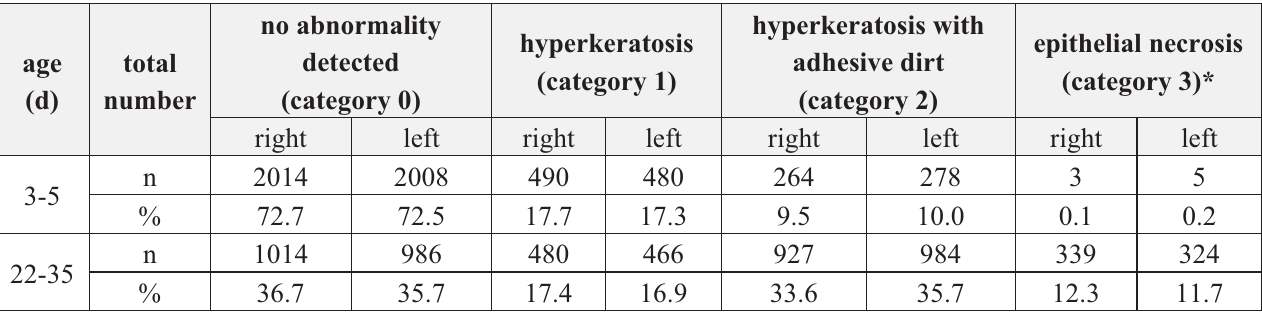
Table 4. Numeric and percental numbers of clinical assessed foot pad alterations per age group (Day 3 to 5 and Day 22 to 35) and gender (n = 5,531 poults; male: 3,131; female: